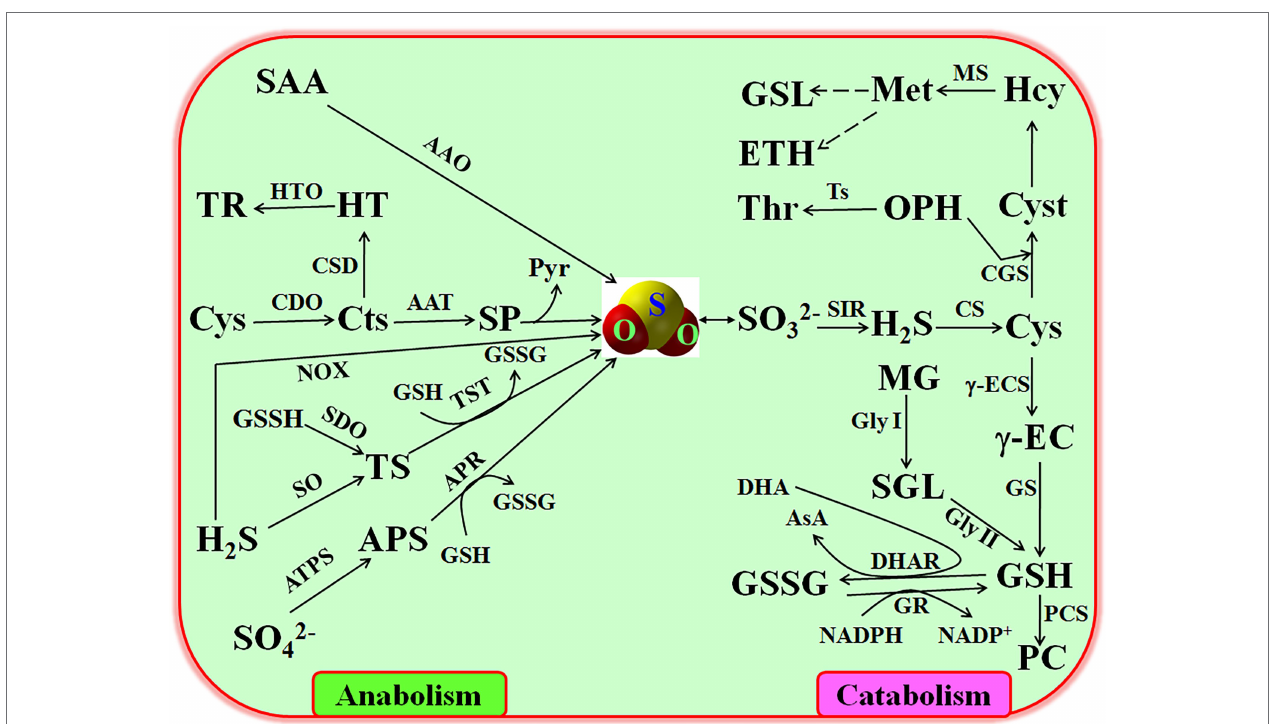
FIGURE 1 | Anabolism and catabolism of sulfur dioxide (SO 2 ) in plants. AAO, amino acid oxidase; APR, APS reductase; APS, adenosine 5 ′ -phosphosulfate; ATPS, ATP sulfurylase; CDO, cysteine dioxygenase (CDO); CS, Cys synthetase; Cts, cysteine sulfinate; Cys, cysteine; Cyst, cystathionine; DHAR, dehydroascorbate reductase; γ -ECS, γ -glutamycysteine synthetase; Gly I, glyoxalase I; Gly II, glyoxalase II; GR, glutathione reductase; GS, GSH synthesis; GSH, glutathione; GSL, glucosinolate; GSSG, oxidized GSH; Hcy, homocystine; H 2 S, hydrogen sulfide; Met, methionine; MG, methylglyoxal; NOX, NADPH oxidase; OPH, O-phosphohomoserine; PC, phytochelatin; Pry, pyruvate; SAA, sulfur-containing amino acids; SGL, S-D-lactoylglutathione; SIR, sulfite reductase; SO, sulfide oxidase; SP, β -sulfinylpyruvate; Thr, threonine; Ts, threonine synthetase; TS, thiosulfate; TST, TS